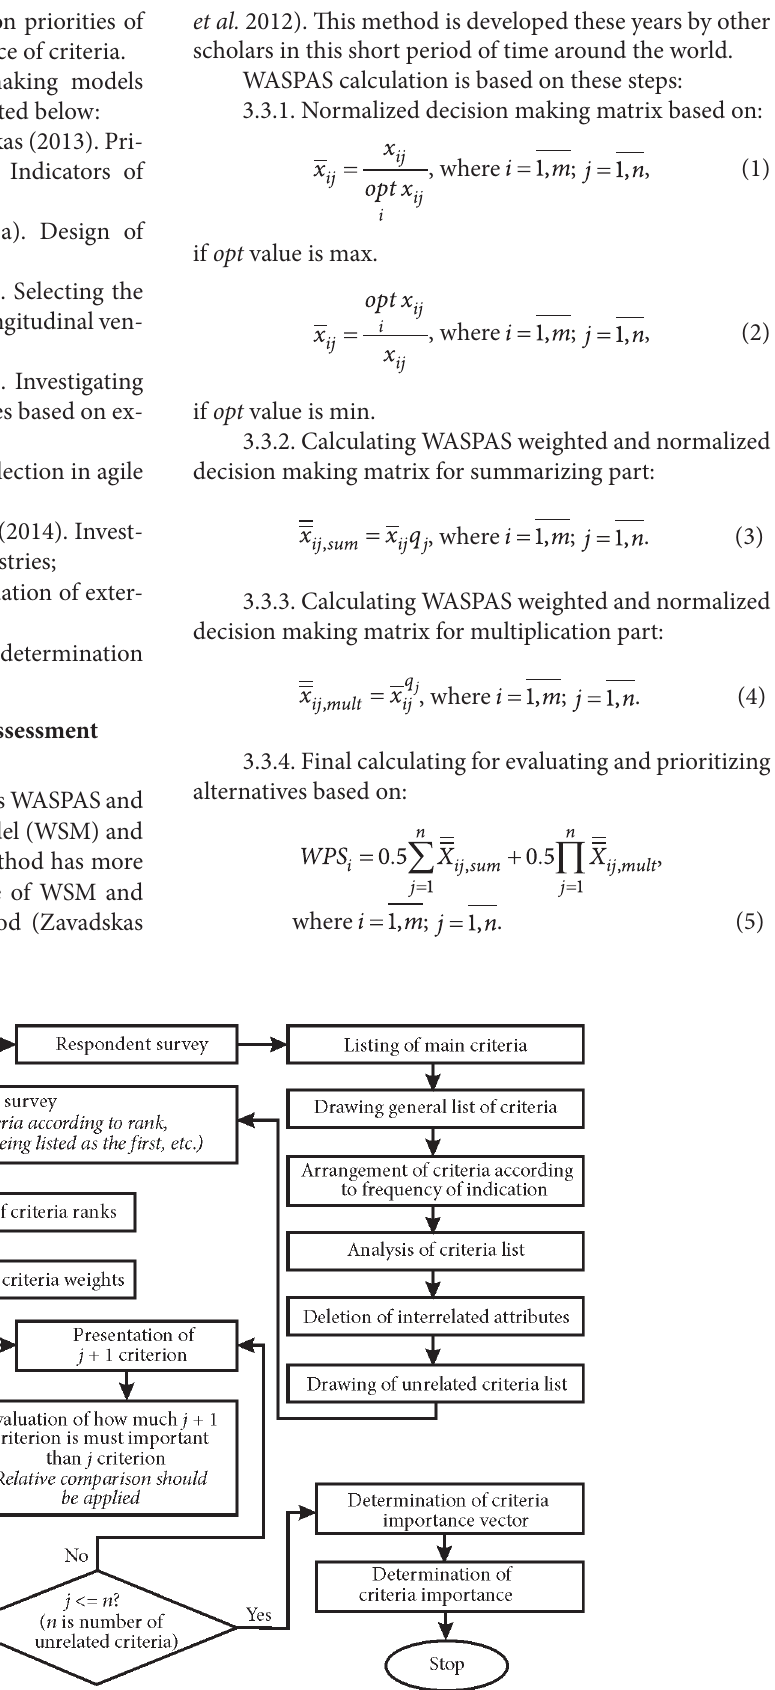
Fig. 2. Determining of the criteria weights based on (Keršulienė, Turskis